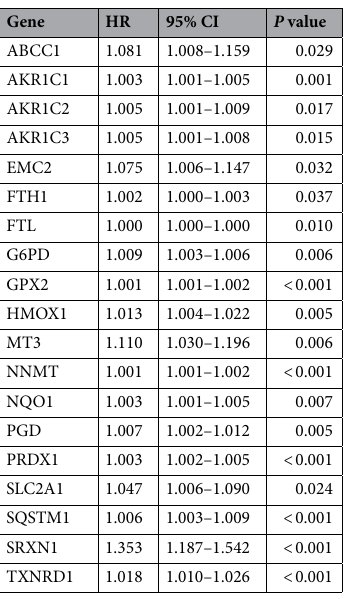
Table 1. Univariate Cox Regression Analysis of DEGs in The Cancer Genome Atlas. Abbreviations: HR, hazard ratio; CI, confidence